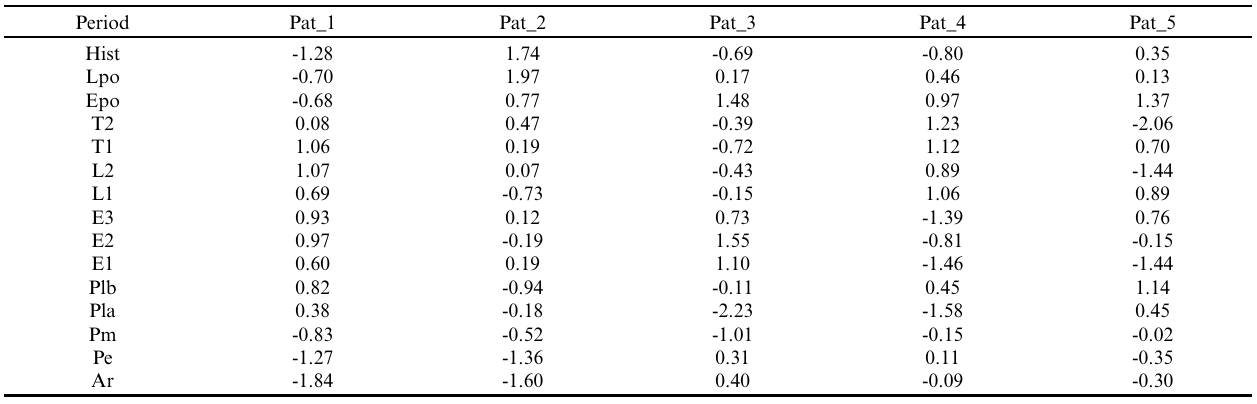
Table 5 . Principal components analysis